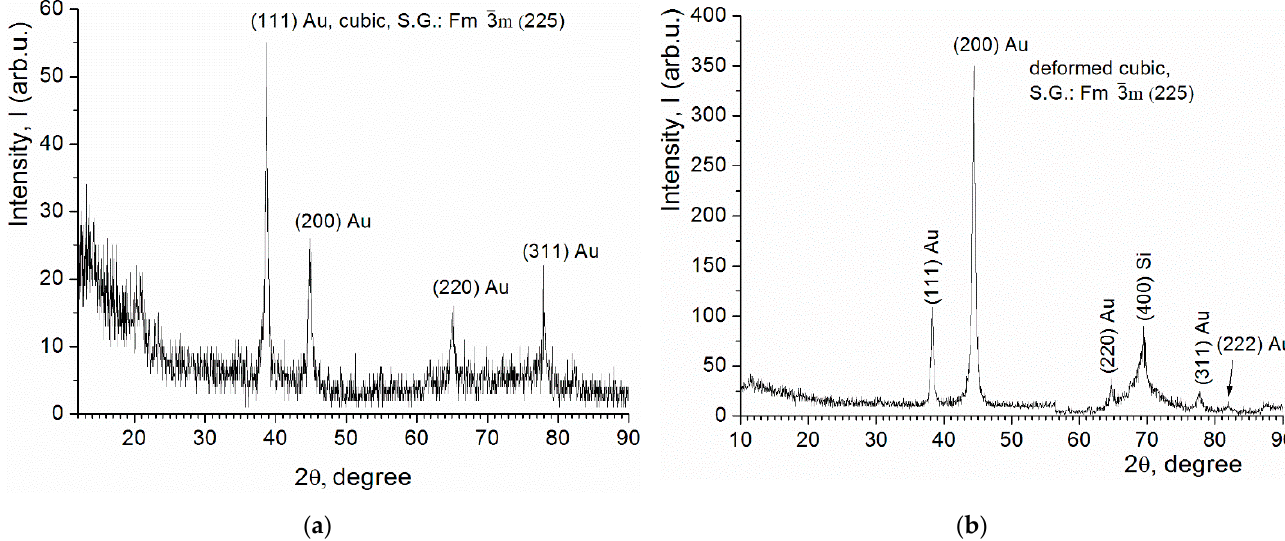
Figure 8. XRD pattern for the macro-PS after 50 min ( a ) and 80 min ( b ) of Au deposition.